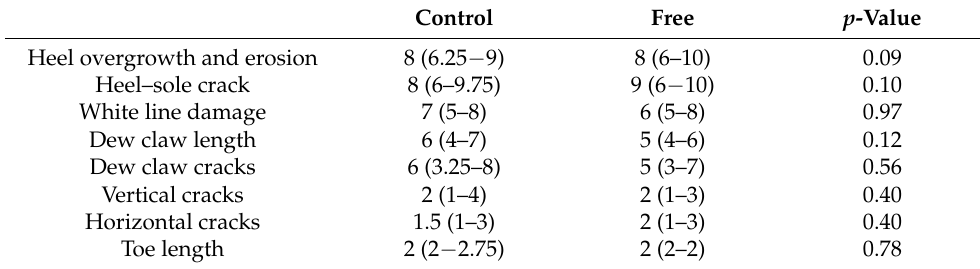
Table 2. Hoof disorder scores for sows in the Control and Free treatments. Data are presented as medians and inter-quartile ranges.